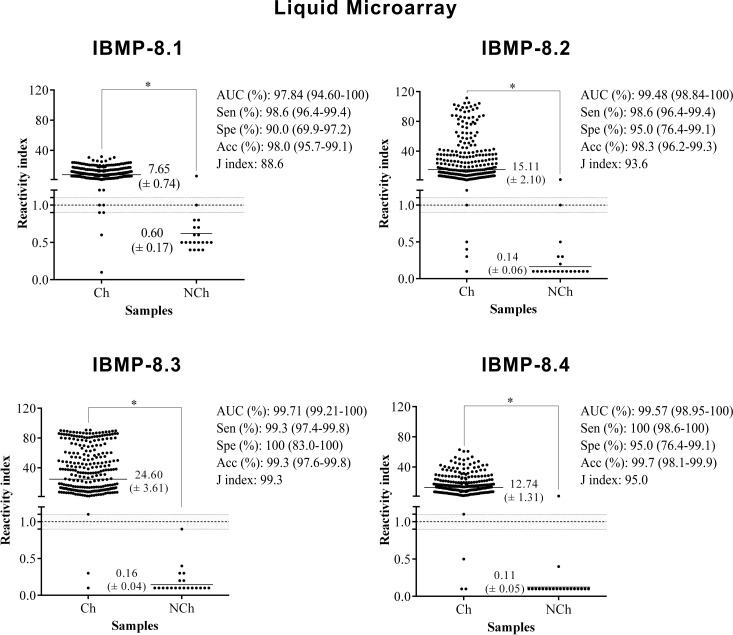
Anti-Trypanosoma cruzi IgG level in serum samples from chagasic (Ch) and non-chagasic (NCh) individuals assayed by liquid microarray.The cut-off value is 1.0 and shadowed area represents the grey-zone. Horizontal lines and numbers for each group of results represent the geometric means (± 95%CI).